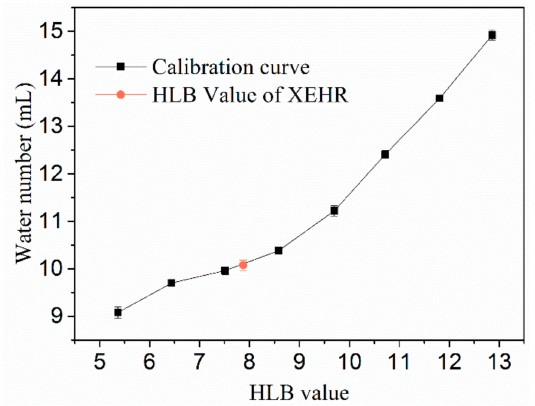
Figure 3. The hydrophilic–lipophilic balance (HLB) calibration curve (based on Greenwald et al.) and the HLB values for the XEHR. The plot of water number vs. HLB was obtained from Equation (2) using span-80 and tween-80 mixtures.